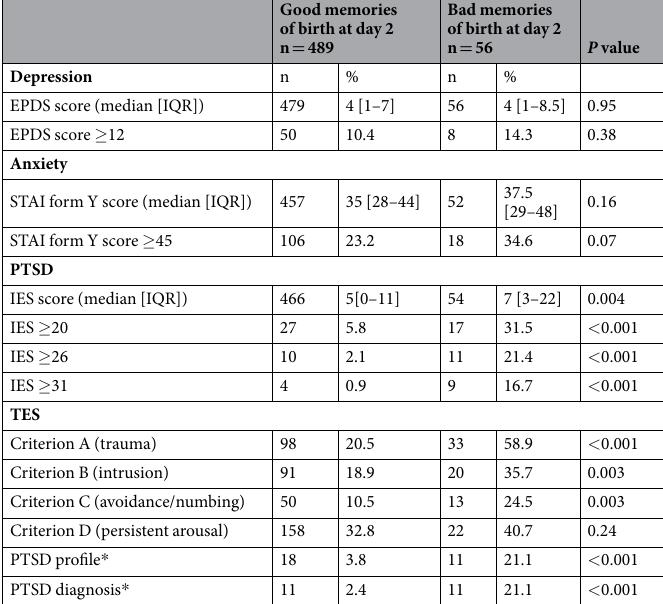
Good memories of birth at day 2 n = 489